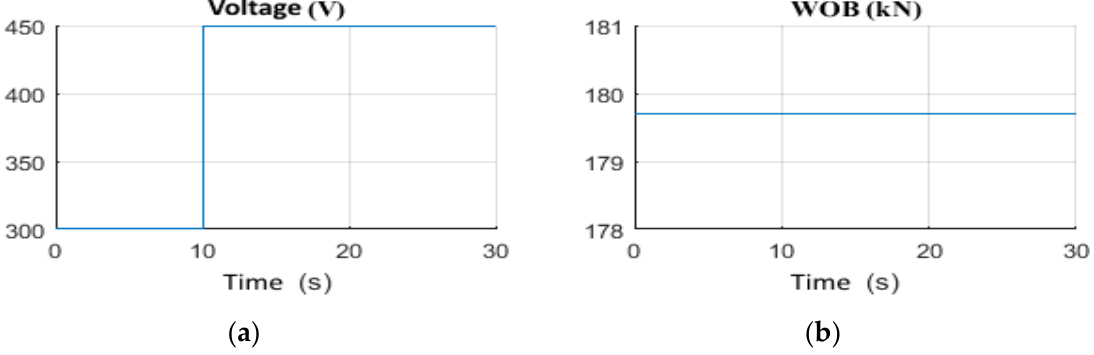
Figure 12. Test inputs of the observer for Scenario-3: ( a ) Top drive motor voltage, ( b ) Applied Weight on bit.